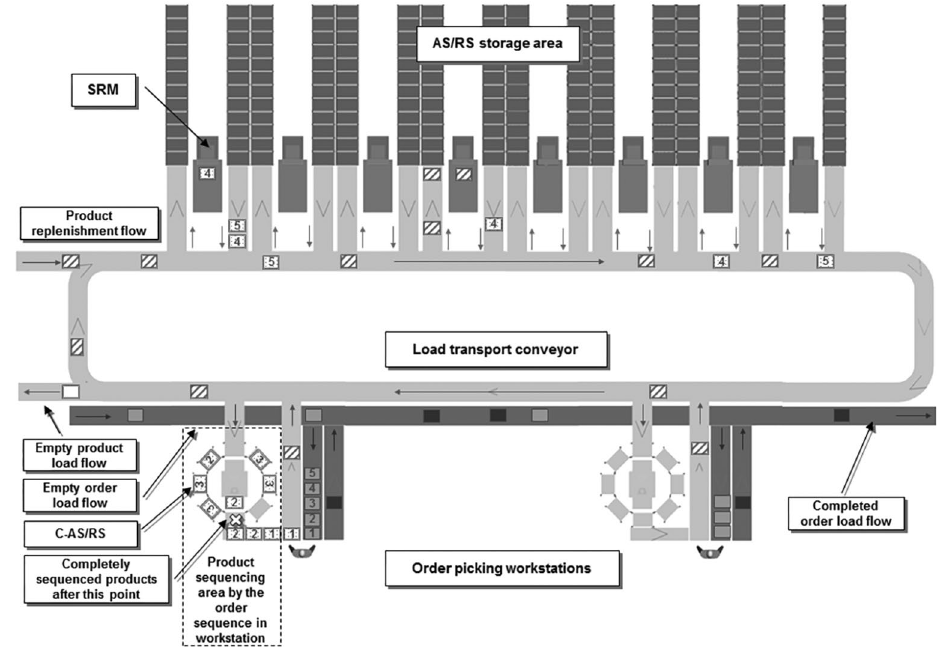
Fig. 2. C-AS/RS integration to OPS